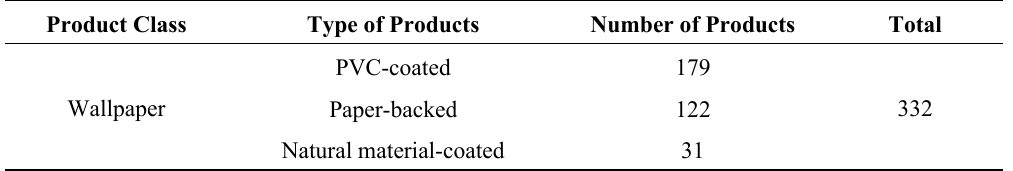
Table 1. Type and number of wallpaper products tested in this study.